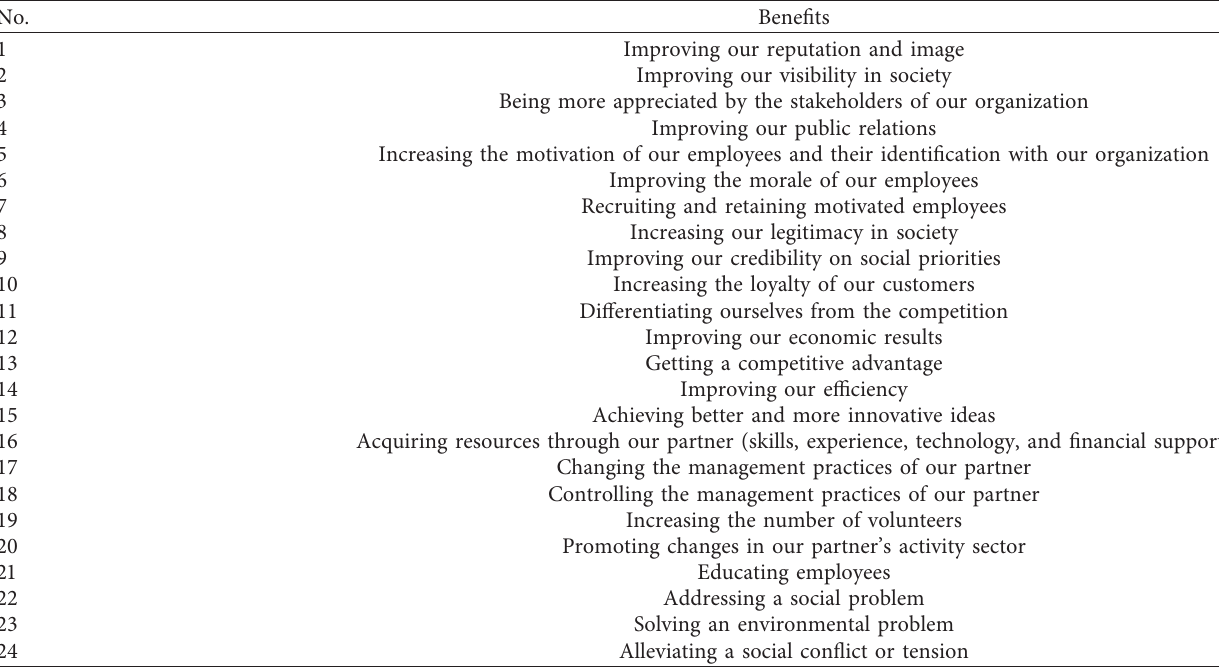
Table 2: Individual benefits of businesses and NPOs.